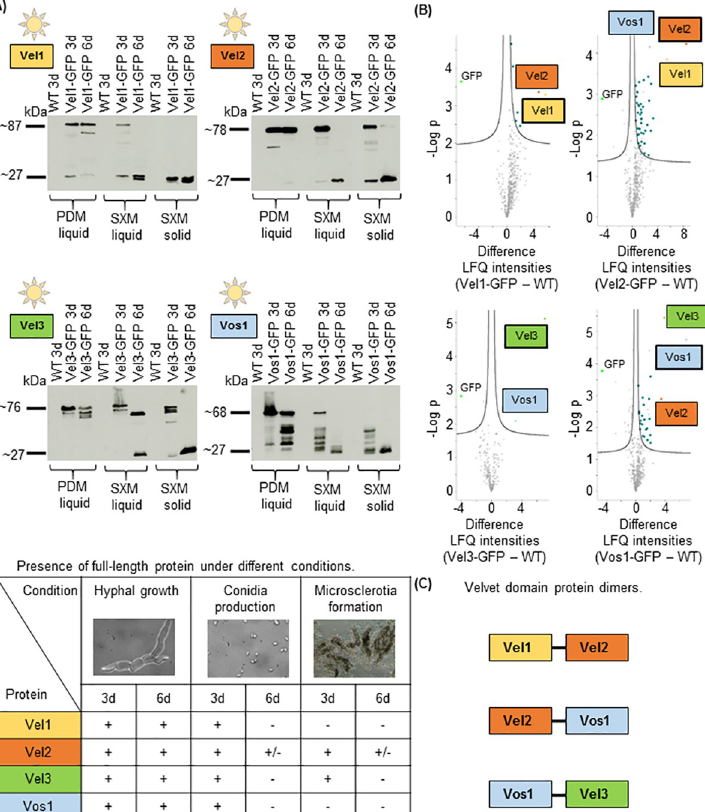
Fig 5. Velvet domain proteins during vegetative growth and development of V . dahliae . (A) Western hybridization with a GFP antibody for velvet domain proteins fused to GFP in extracts from V . dahliae strains of VEL1 - GFP , VEL2 - GFP , VEL3 - GFP and VOS1 - GFP grown during conditions stimulating filamentous growth (PDM: liquid potato dextrose medium), conidia (SXM: pectin-rich simulated xylem medium) or microsclerotia (SXM plates covered by a nylon membrane) formation. 1x10 6 freshly harvested spores were inoculated and extracts were prepared after growth for three and six days at 25˚C in light (free GFP: 27 kDa; Vel1-GFP: 87 kDa; Vel2-GFP: 78 kDa; Vel3-GFP 76 kDa; Vos1-GFP: 68 kDa). Presence (+) or absence (-) of full-length proteins during different conditions is summarized in the table below. (B) Vel1-3-GFP and Vos1-GFP interacting proteins during filamentous vegetative V . dahliae growth. Spores from the strains mentioned in (A) were grown in liquid PDM during constant light at 25˚C for 72 h, subjected to GFP-trap-pull-down, trypsin digested and resulting peptides were analyzed by LC/MS. Volcano plots show differences of examined velvet-GFP fusion proteins in comparison to wild type (WT) on x-axis and -Log p values on y- axis. Displayed is the mean of three independent experiments. Significant hits of the pull-down are visible in the upper right part. Missing values were replaced four times with imputed values to obtain reliable interaction candidates. Proteins that were significant in all four repetitions are colored (Vel1: yellow, Vel2: orange, Vel3: green, Vos1: light blue, other proteins: dark blue). GFP is indicated in lime and the bait is framed by a black line. Vel1 interacts with six other proteins including Vel2; Vel2 interacts with Vel1 and Vos1 and 40 other proteins; Vel3 interacts with Vos1; Vos1 interacts with Vel2 and Vel3 as well as 21 other proteins. (C) Summary of the velvet domain dimer complexes identified during V . dahliae vegetative growth. of cultivation (Fig 5A). Vel2 increases microsclerotia production specifically in light. Consis- tently, Vel2-GFP is more stable in light than in darkness (SXM solid, S22 Fig). Asexual sporu- lation happened independently of Vel2 and revealed a different stability pattern. During conidiation, Vel2-GFP is destabilized in light, but more stable in darkness (SXM liquid, S22 Fig). During filamentous growth Vel2-GFP is stable in light as well as in darkness (liquid PDM, S22 Fig). Again, signals of potential degradation products as well as of free GFP were observed.